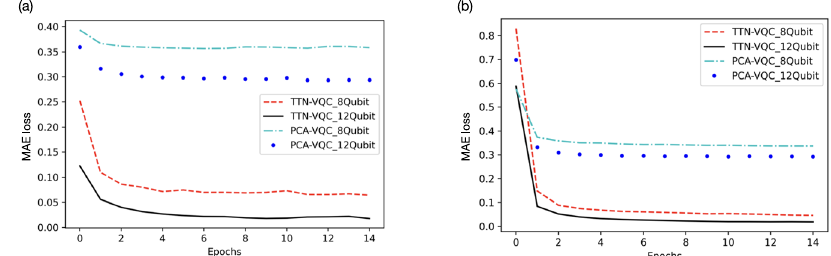
Fig. 5 Empirical results of the vector-to-vector regression on the MNIST dataset to evaluate the representation power of TTN-VQC. a MAE loss values on the training data. b MAE loss values on the test data. TTN-VQC_8Qubit and TTN-VQC_12Qubit represent the TTN-VQC models with 8 and 12 qubits, respectively; PCA-VQC_8Qubit and PCA-VQC_12Qubit separately denote the PCA-VQC models with 8 and 12 qubits.